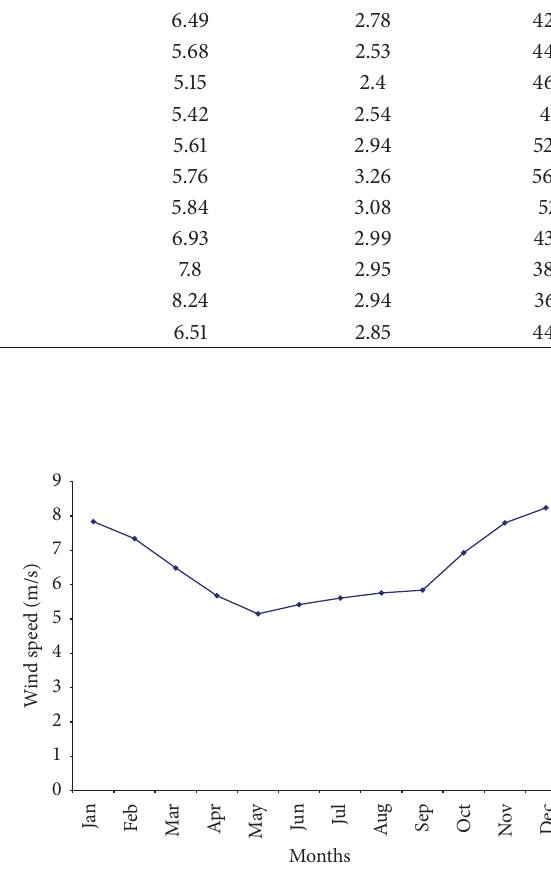
Figure 4: Values of monthly mean 10 m wind speed for the period 1980–2009 in the ECS, unit: m/s.